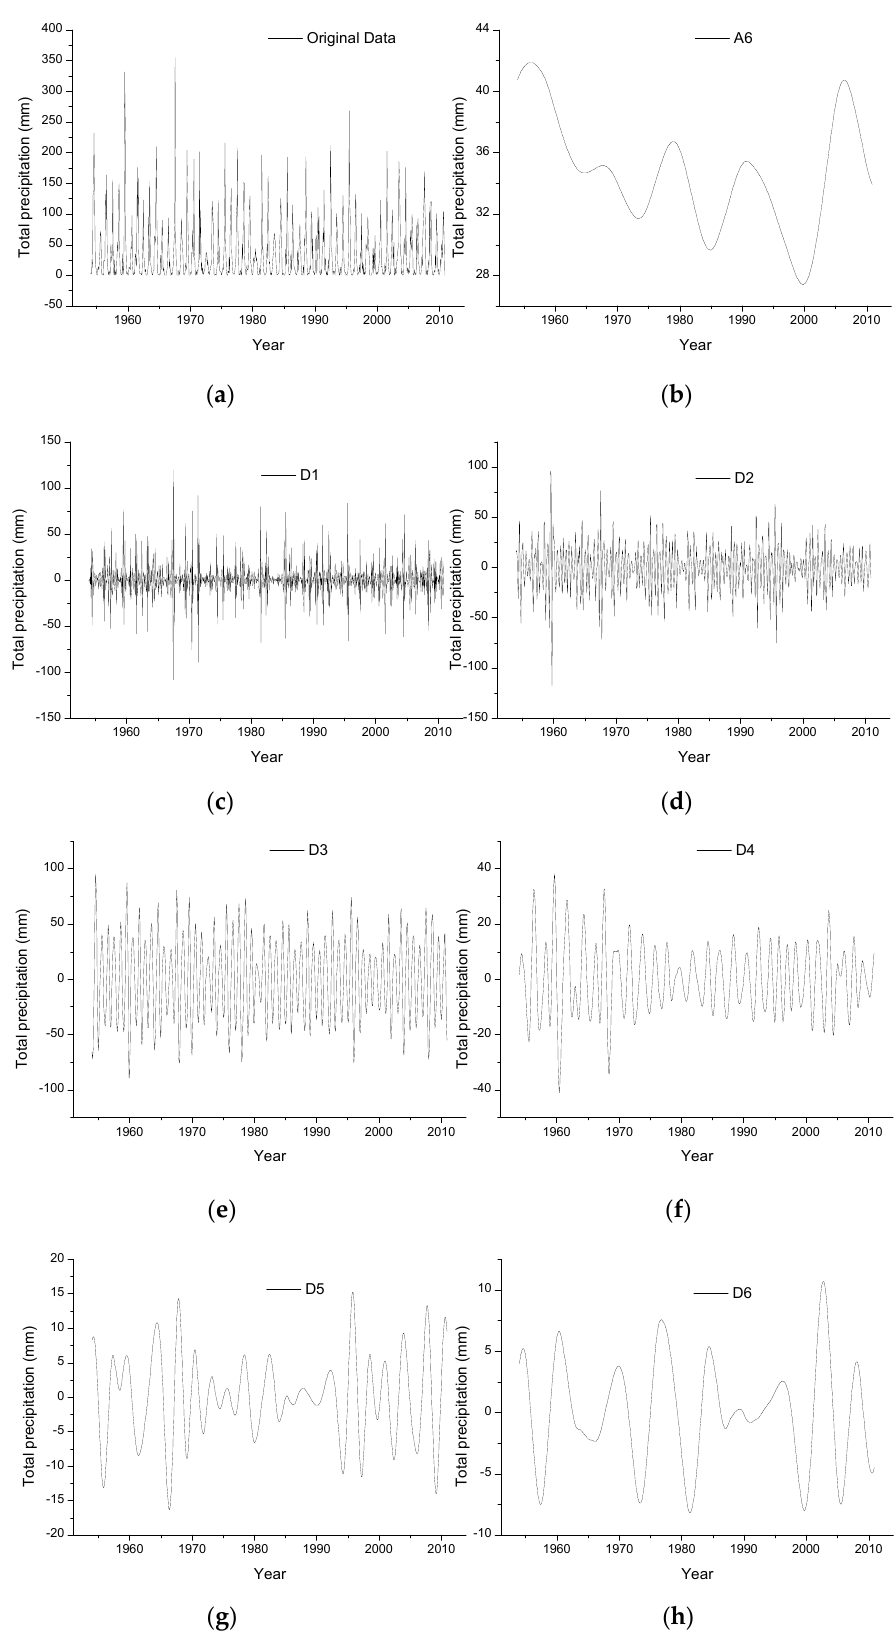
Figure 7. Original monthly mean streamflow series and its approximation (A7) and detail components (D1–D7) decomposed via DWT. ( a ) original data; ( b ) A7; ( c ) D1; ( d ) D2; ( e ) D3; ( f ) D4; ( g ) D5; ( h ) D6; ( i ) D7.